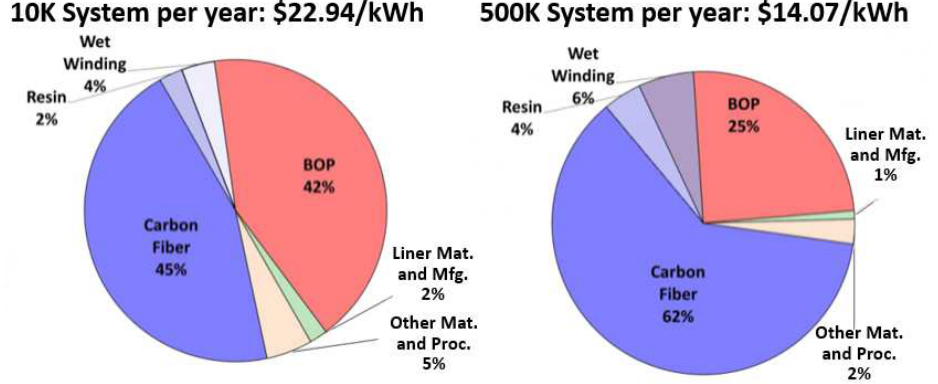
Figure 7. Cost breakdown of 70 MPa tank type IV system